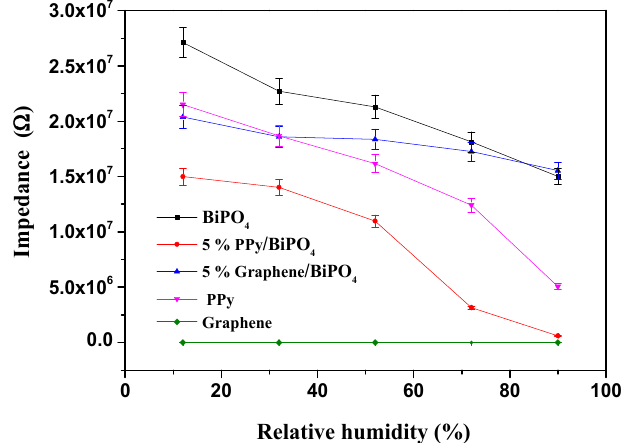
Figure 5. Discrepancies in impedance relative to the variations in relative humidity (%) for varying (Gr/PPy)-BiPO 4 composite contents.